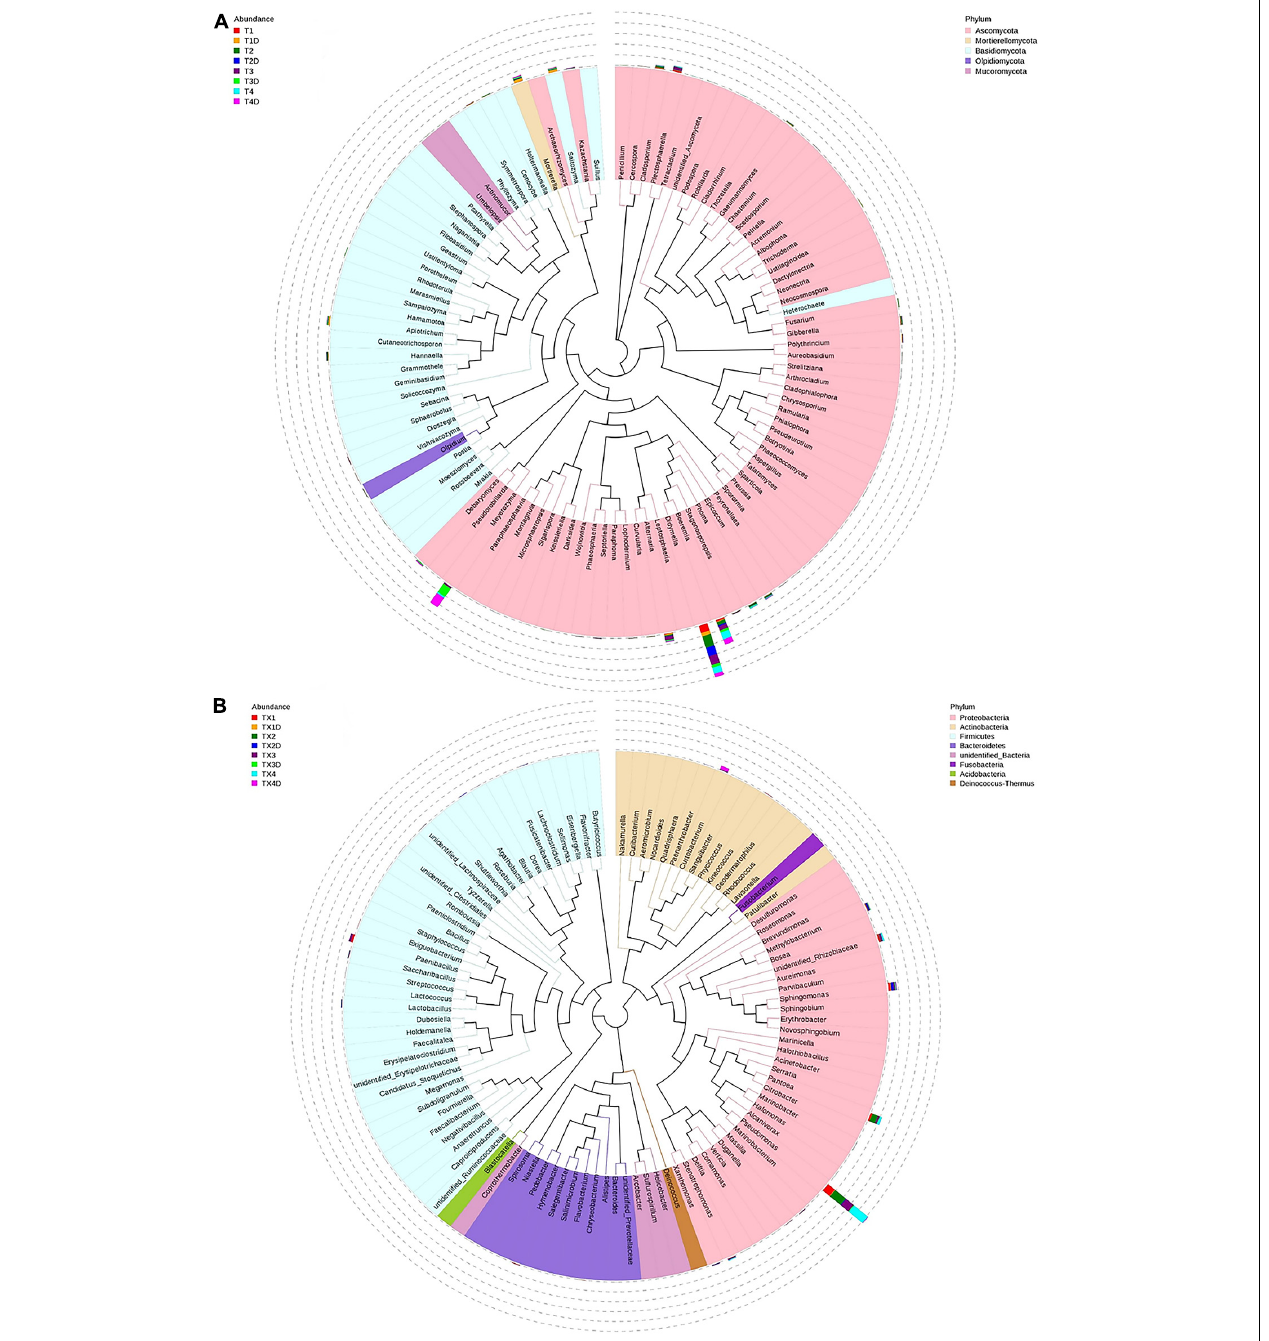
FIGURE 5 | Maximum likelihood tree of the 100 most abundant fungal (A) and bacterial (B) genera in the eight group samples from tobacco leaves infected with D. segeticola. obtained by analysis of ITS rDNA and 16S rRNA pyrosequencing data. A color-coded bar plot shows the distribution of each fungal and bacterial genus in different